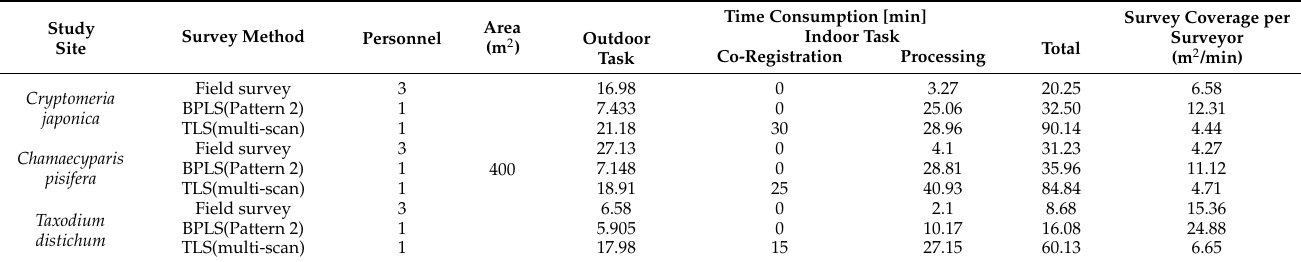
Table 13. Comparison of efficiencies for the BPLS, TLS and field